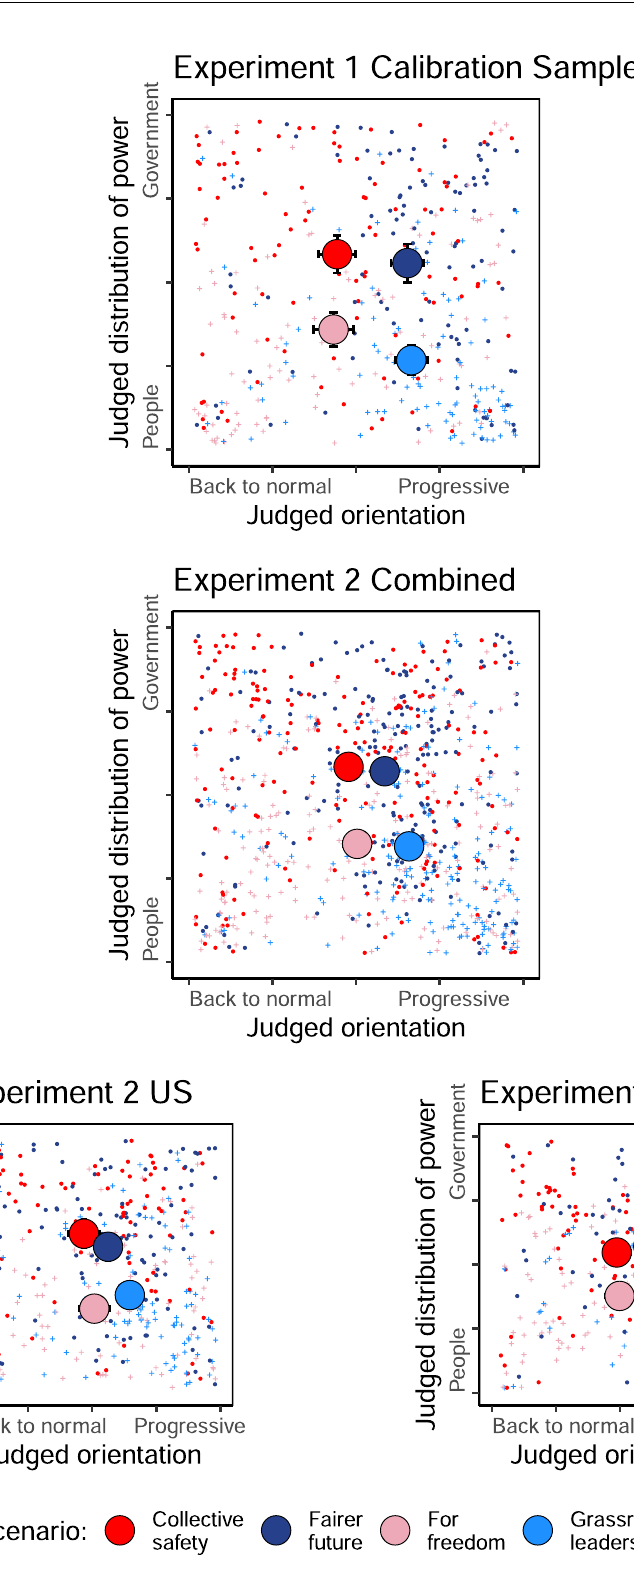
Fig. 2 Results of scenario calibration when participants were asked to rate each scenario along the dimension instantiated by each experimental variable. The top panel reports the study embedded in Experiment 1, and the remaining panels show the calibration responses from Experiment 2 for both samples combined (center panel) and the individual samples (bottom row of panels). In each panel, large plotting symbols represent means along the two dimensions and error bars represent 95% con fi dence intervals. Individual responses are shown by small symbols with jitter to avoid overprinting.